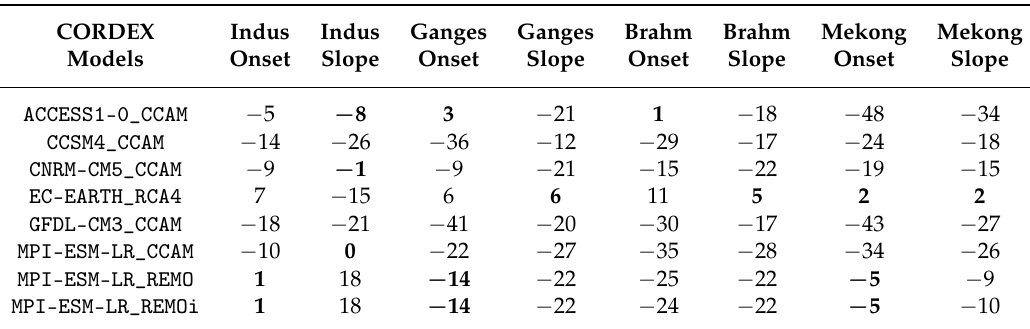
Table 3. Offsets of onset (in days) and RFA slope (%) in CX-SA experiments relative to CMIP5 experiments. Note: Negative values indicate early onset or underestimated slopes and vice versa. Bold values indicate statistically insignificant difference between the climatological means of CX-SA and their CMIP5 driving datasets.